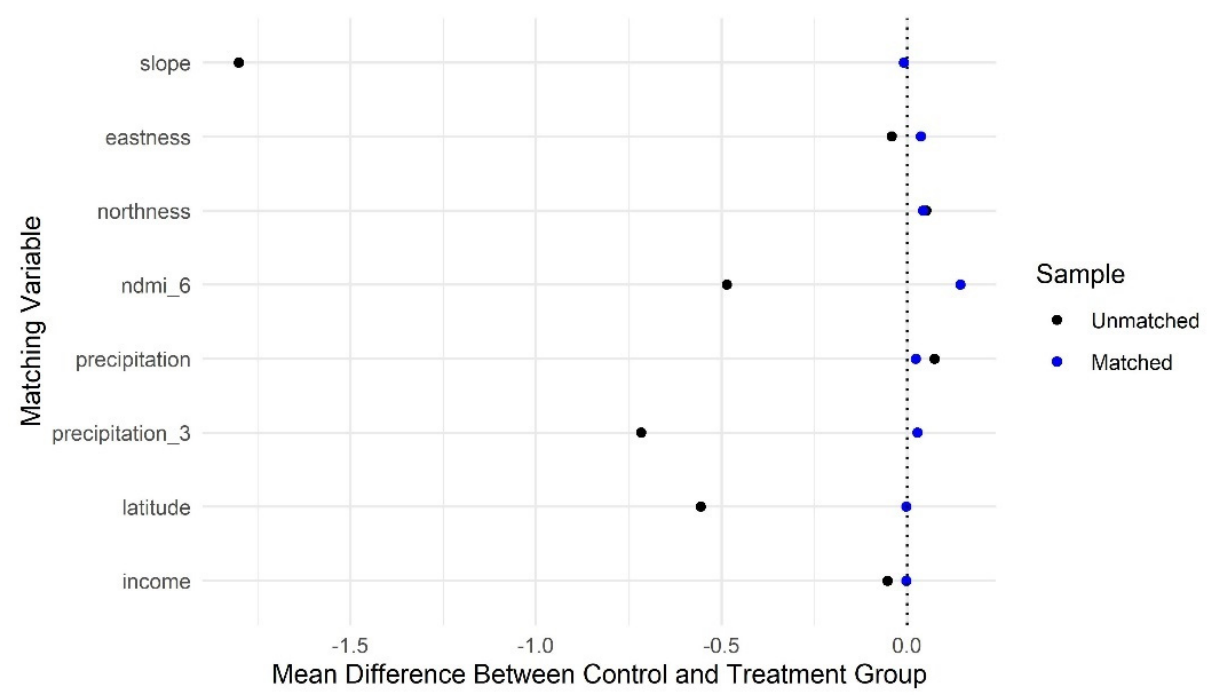
Figure 2. Love plot for the standardized mean differences for the continuous matching variable prior to and after the PSM generated by using the ‘cobalt’ package in R [47]. Exact matches on categorical data such as landcover and fire name have been removed from this plot.